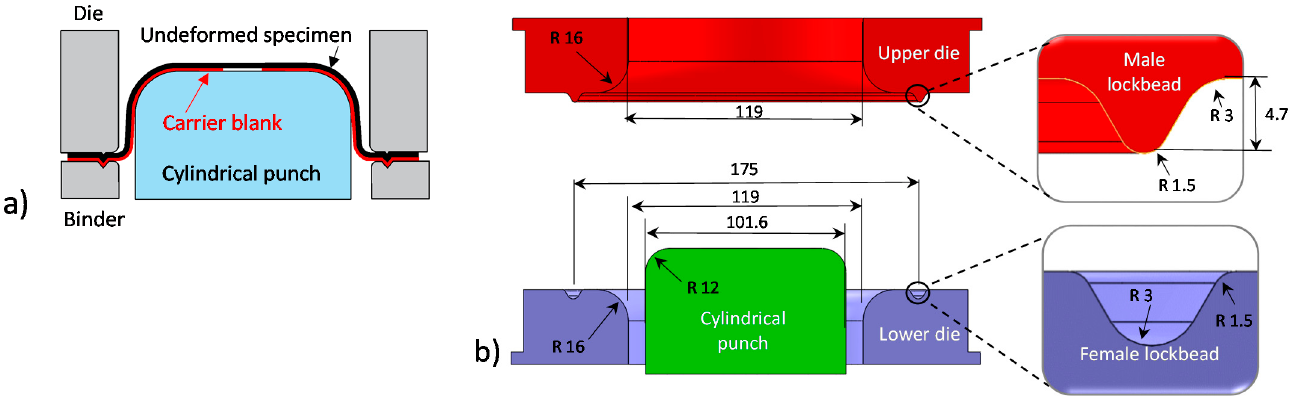
Figure 21. Schematic of methodology of Marciniak tests to characterize the limit strain under in-plane loading ( a ) and geometric dimensions of the tool set corresponding to the ISO12004-2 standard adapted from Gutierrez et al. [12]. All units are in mm ( b ).